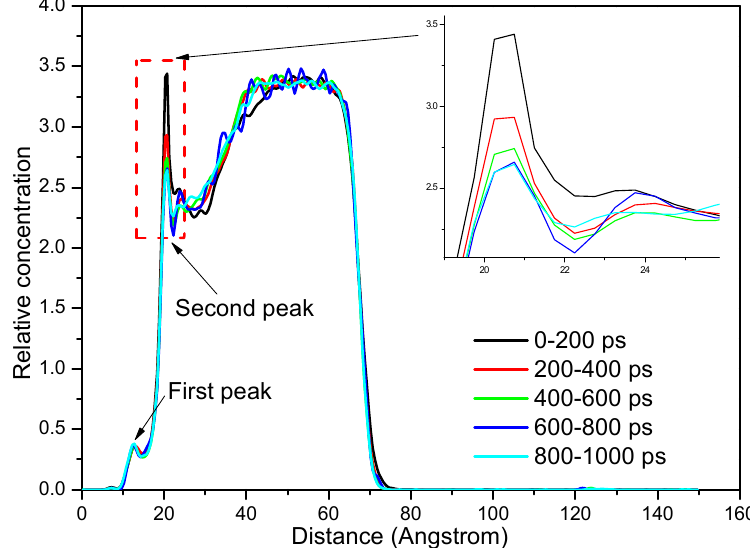
Figure 10. Relative concentration distribution of water molecules as a function of simulation time.